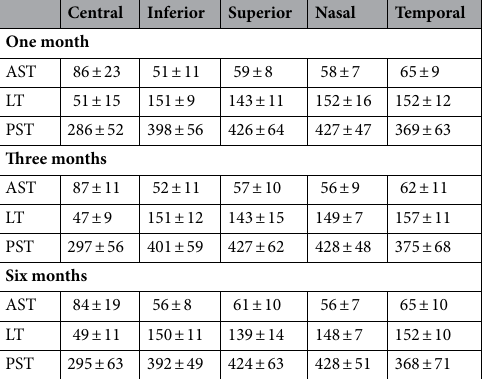
Table 2. Anterior stromal thickness (AST), lenticule thickness (LT) and posterior stromal thickness (PST) at 1, 3 and 6 months after surgery in the central area and on 3-mm central radius (Mean ± SD). Statistically significant differences were not observed between the follow-up time